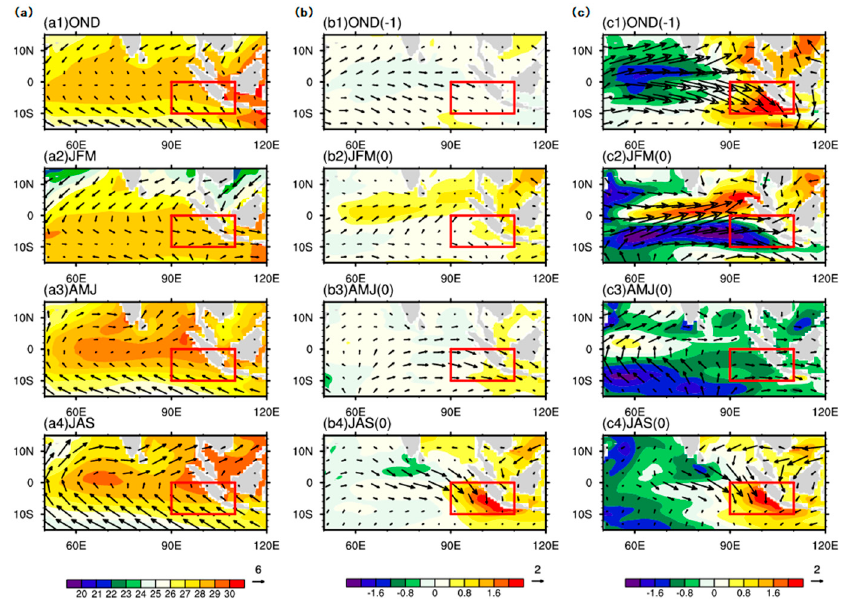
Figure 11. ( a ) Seasonal evolutions for the SST (shaded; units: °C) and surface wind (vectors; units: m/s) of climatological state in Indian Ocean. Seasonal evolutions of SST errors and wind anomalies induced by the type-1 initial errors for ( b ) the pure IOD events and ( c ) the pIOD events that occurred with El Niño with the start month being October ( − 1). The red rectangle denotes the location of the southeastern IO.